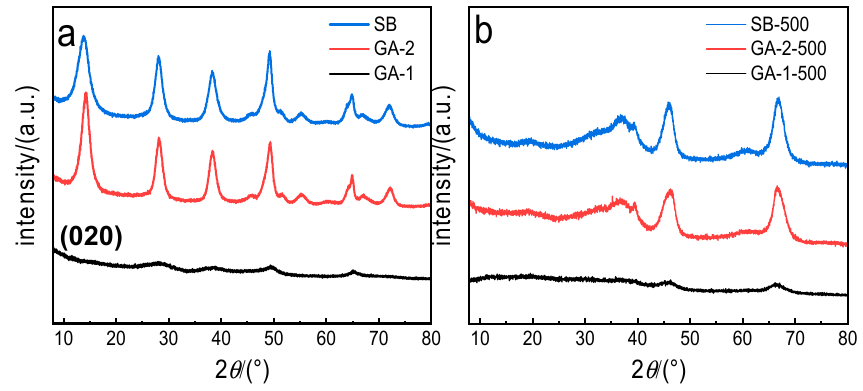
Figure 1. X-ray diffraction (XRD) patterns of ( a ) boehmite and ( b ) alumina adsorbent. Figure 1. X-ray di ff raction (XRD) patterns of ( a ) boehmite and ( b ) alumina